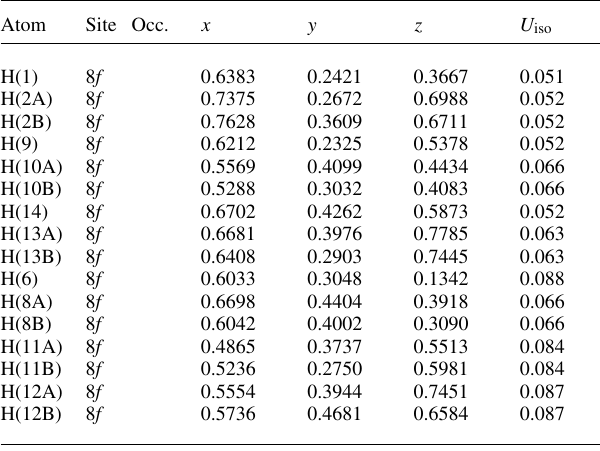
Table 2. Atomic coordinates and displacement parameters (in Å 2 )